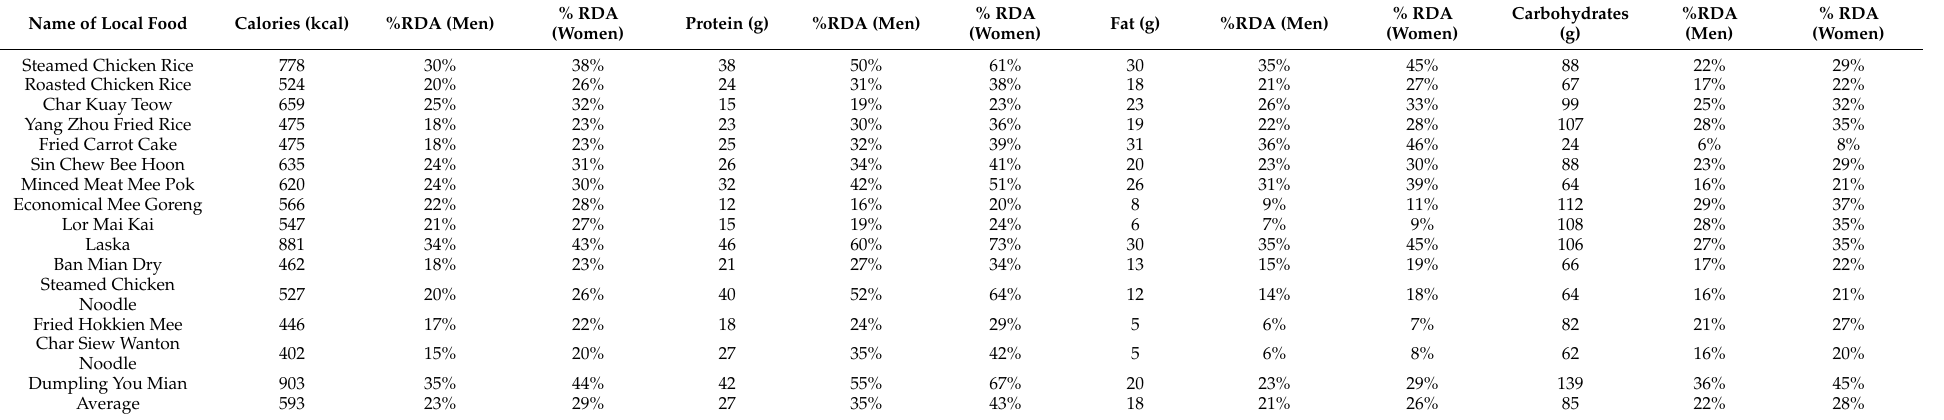
Table 4. Energy and macronutrient content and the %RDA of the commonly consumed Chinese cuisines.